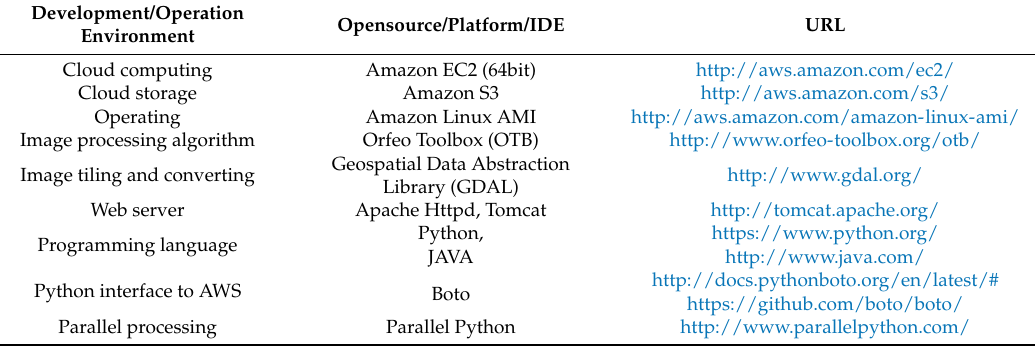
Table 1. Development environment and open sources for the implementation of the cloud